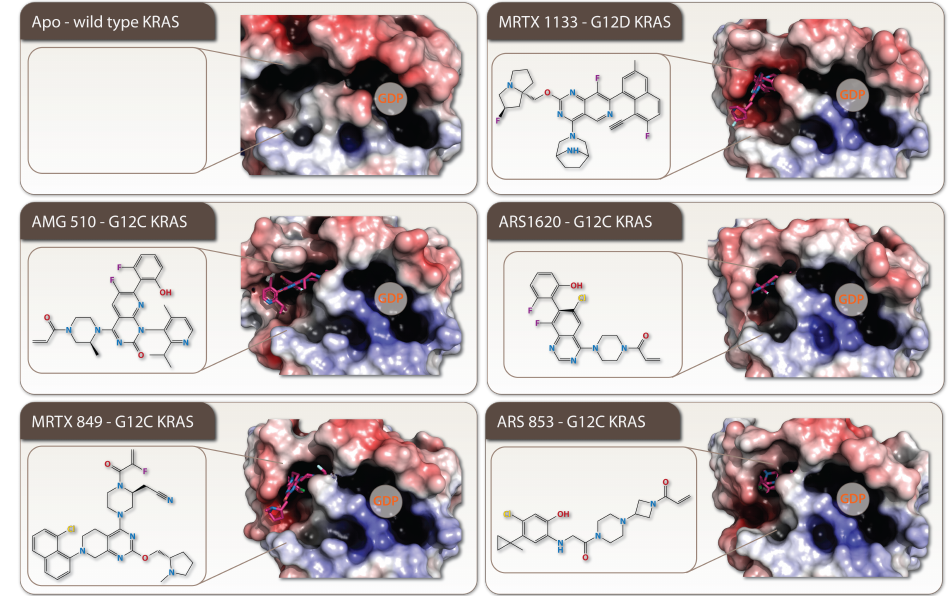
Figure 3. The recent advances in RAS inhibitor design. Five representative examples of recently development RAS inhibitors AMG 510 (PBDID 6OIM), MRTX 849 (PBDID 6OIM), MRTX 1133